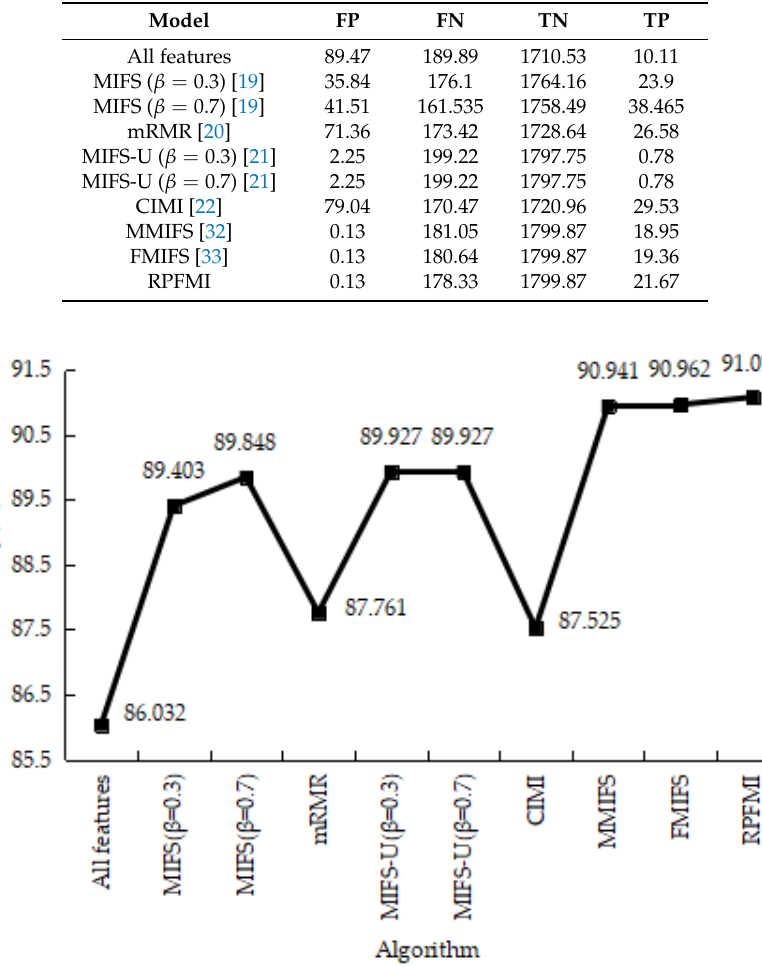
Figure 9. Accuracy on the R2L test data.